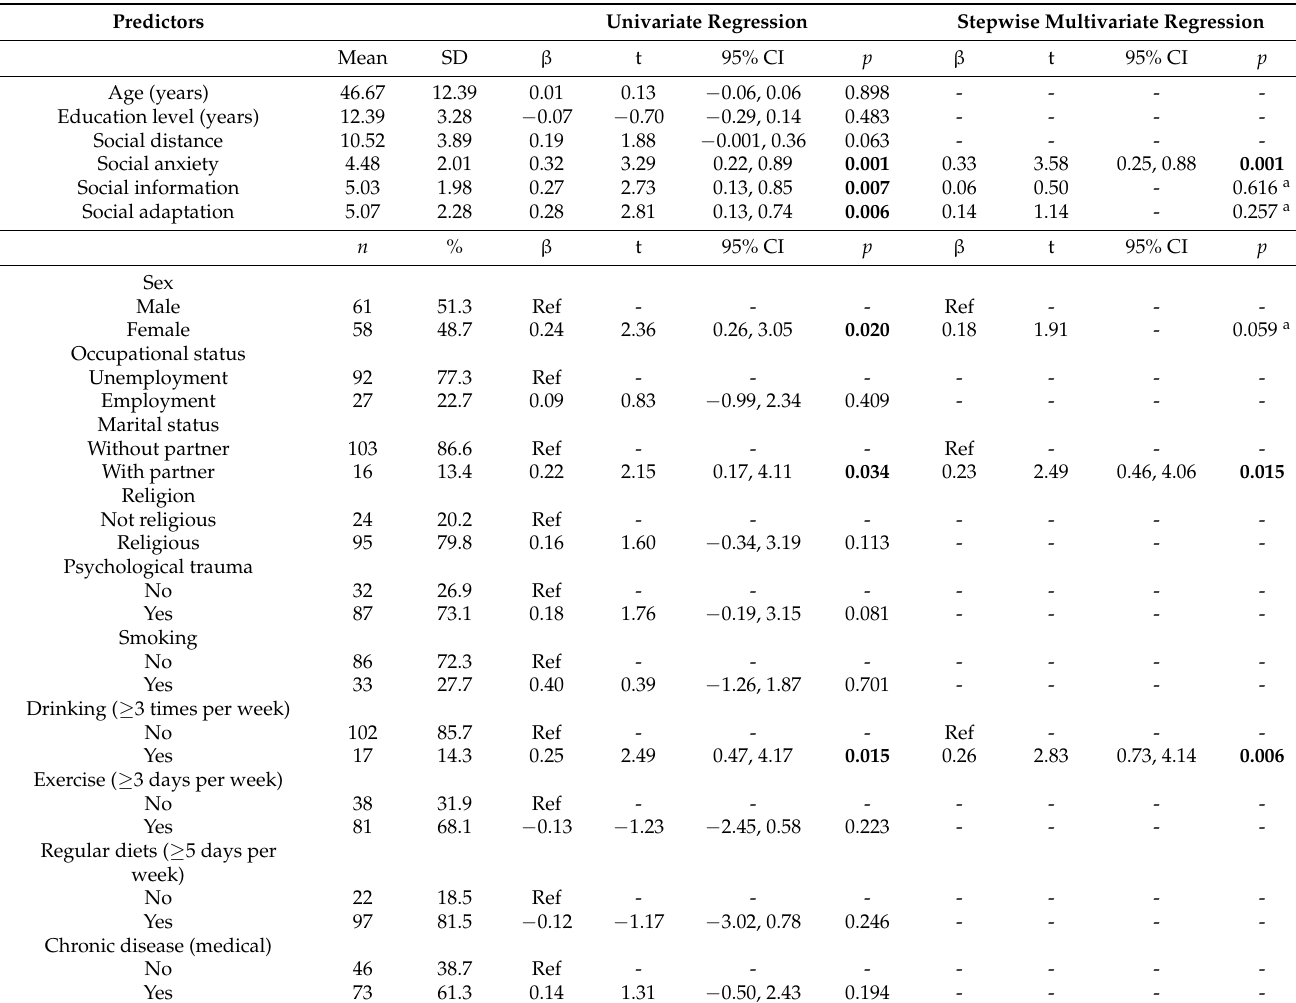
Table 2. Predictors for level of sleep disturbance examined by univariate linear regression and stepwise multivariate linear regression (N =